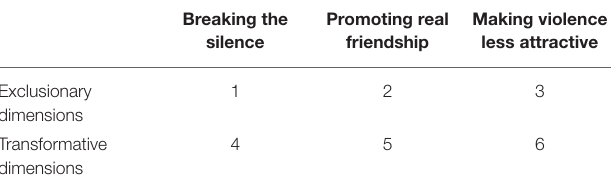
Breaking the Promoting real Making violence silence friendship less attractive 1 2 3 4 5